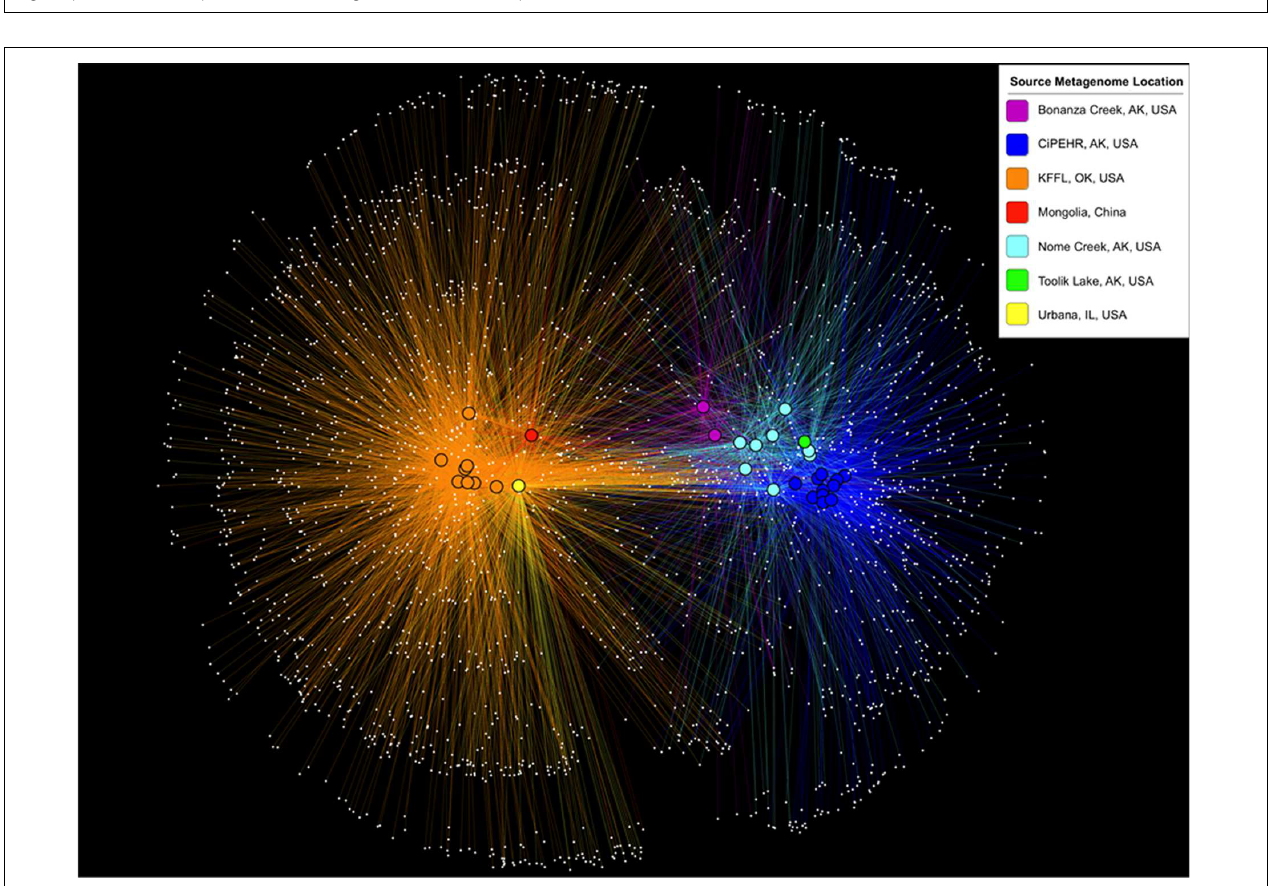
FIGURE 2 | OTU sharing network based on 16S rRNA gene sequences from metagenomes. Samples are clustered (positioned) according to the presence and abundance of their shared OTUs (using make_otu_network.py, a QIIME script; Caporaso et al., 2010). White dots represent OTUs, and a line connecting these dots to a bolded sample dot indicates that the OTU is present in that sample. The colors of lines and bolded sample dots correspond to the source location of each metagenome as provided in the key.